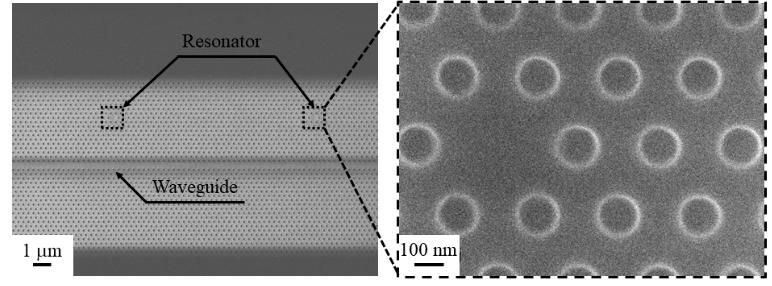
Figure 4. SEM image of polymer-based PhC resonator and waveguide. Micromachines 2018 , 9 , x